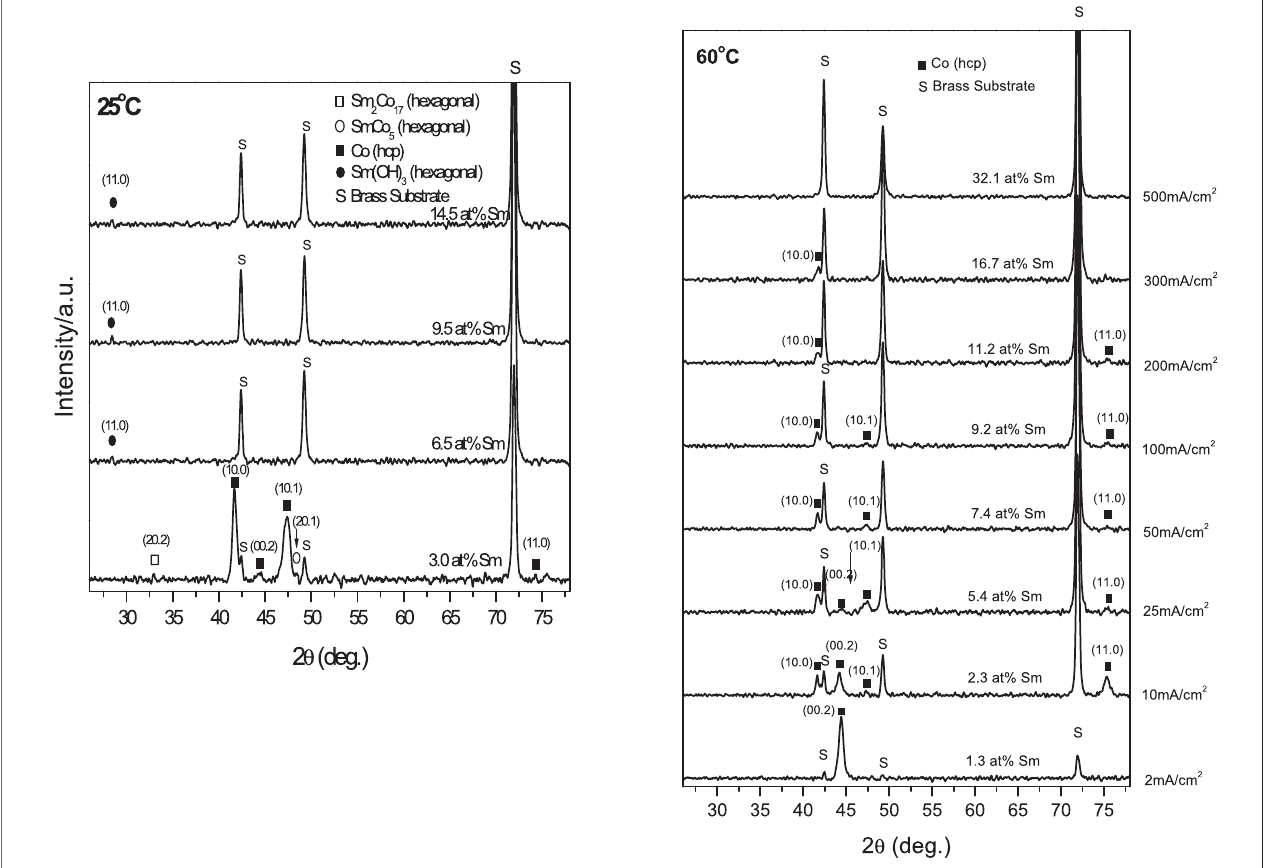
FIGURE 3 | XRD patterns of electrodeposits obtained at different temperature (i.e., 25 and 60 ° C) and various CDs.